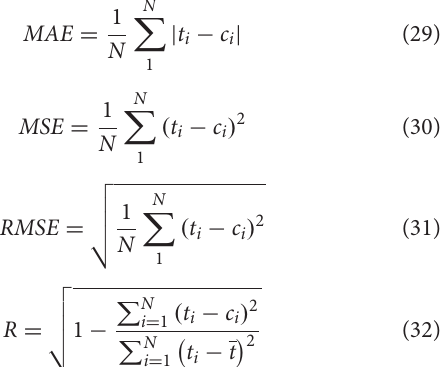
binary image, the average value of the black pixel coordinates at the bottom edge of the image is obtained as the cotyledon node ( Figure 6